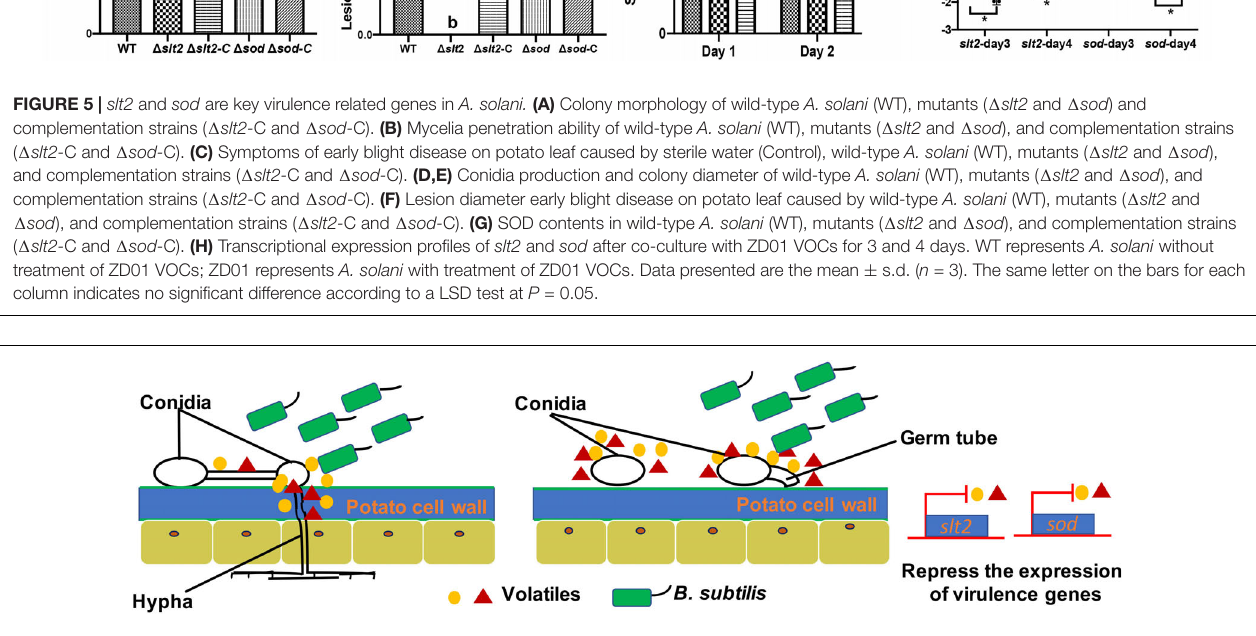
FIGURE 6 | A model for the mode of action of VOCs produced by ZD01 against A. solani . Volatiles produced by ZD01 mediate the conidia germination and mycelium penetration of A. solani . Acetophenone, 6-methyl-2-heptanone, and aniline biosynthesized by ZD01 is the major antifungal compounds against A. solani . These volatiles produced by ZD01 target the conidia and mycelium, which subsequently leads to suppression of fungal growth, mycelium penetration, conidia germination, and pathogenicity of A. solani as well as virulence gene